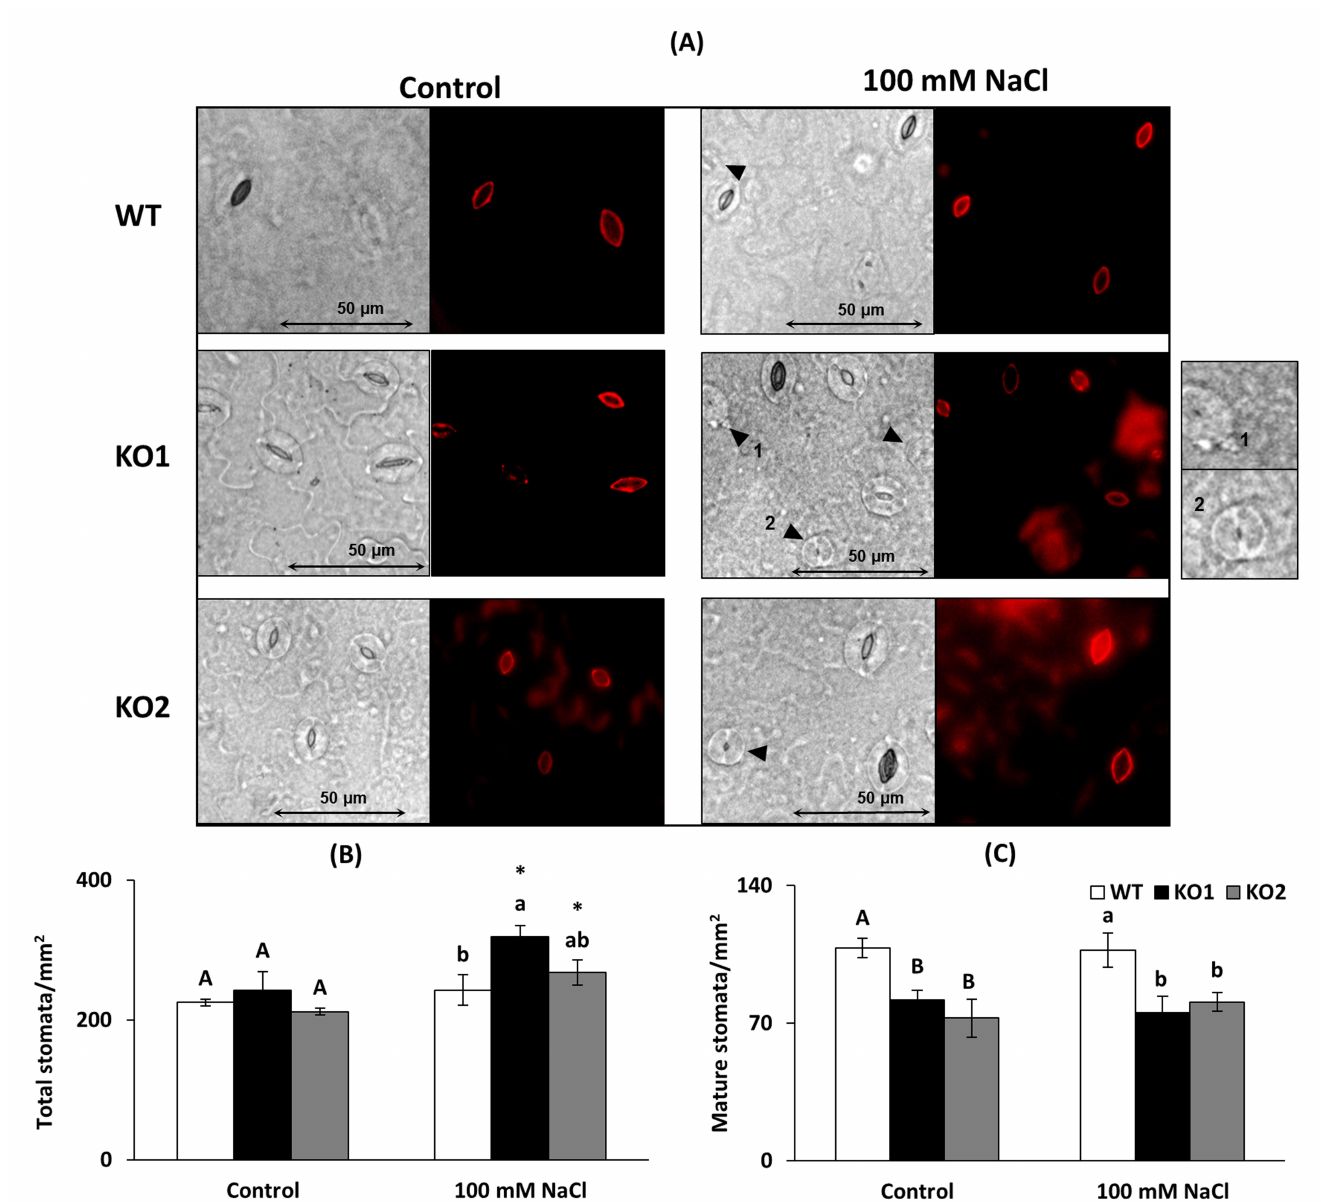
Figure 2. Stomatal characterization. ( A ) Foliar epidermis of A. thaliana wild type (WT) and two KO Attrxo1 mutant lines grown in the absence (Control) and presence of 100 mM of NaCl. Density of ( B ) total (immature and mature) and ( C ) mature stomata. Pictures were captured with a clear field microscope and a 40 × objective. Data are the mean ± SE of three independent experiments ( n > 2000 stomata per genotype and treatment). Different letters indicate significant differences ( p < 0.05) among genotypes in each condition according to the Tukey’s test, and the asterisks indicate significant differences of each genotype in salinity compared to the control condition using the t -Student’s test ( p < 0.05). Arrows point some immature stomata and two of them (1 and 2) are shown in